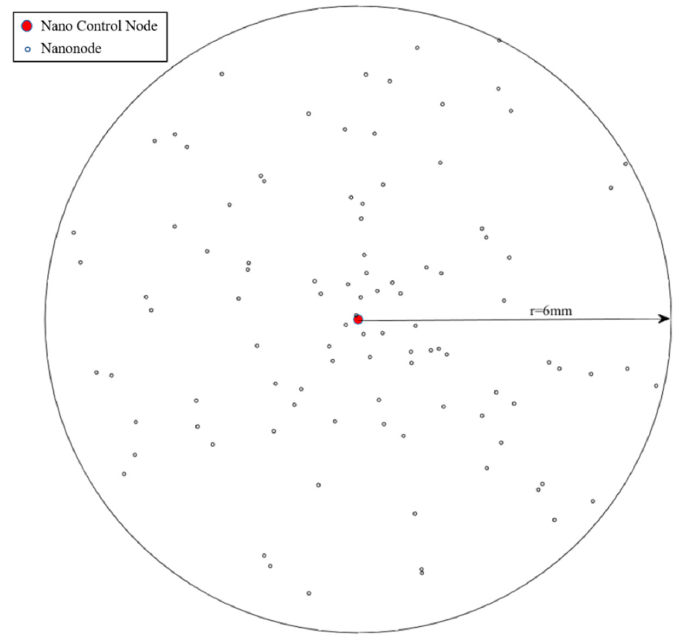
Figure 8. Simulation Scenario.